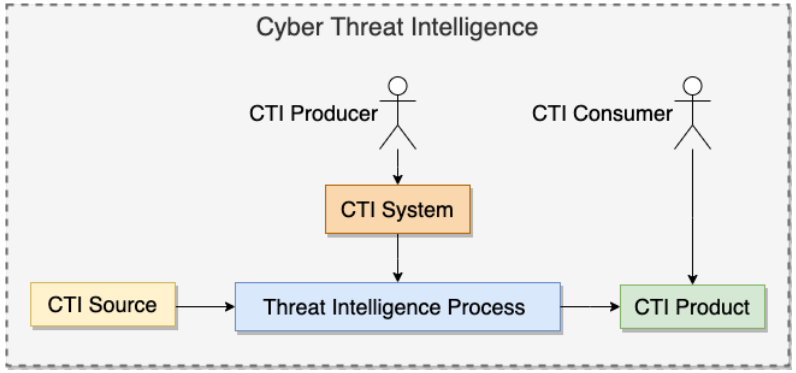
Figure 1. CTI Key Concepts relationships.